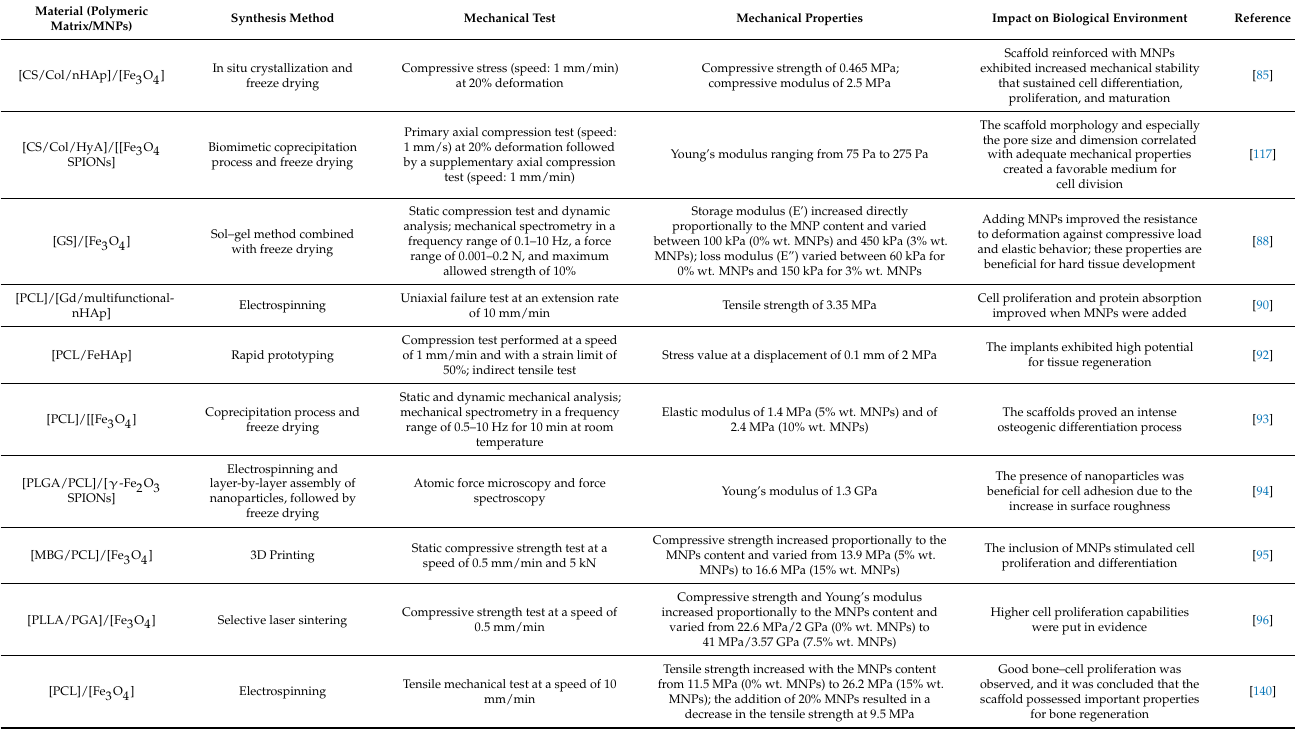
Table 4. Mechanical properties of natural and synthetic polymeric scaffolds loaded with